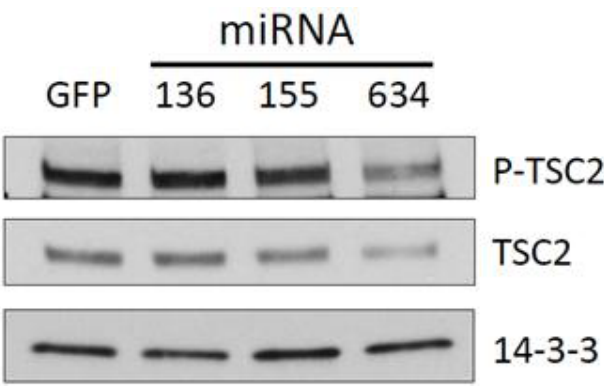
Figure 4. miR-634 reduces the expression of TSC2, a negative regulator of mTOR signaling. Western blot of phospho- and total TSC2. Western blot analysis was performed on lysates from cells that were nucleofected with empty or miRNA-expressing plasmids for 48 h. 14-3-3 antibody was used to show equal loading of cellular